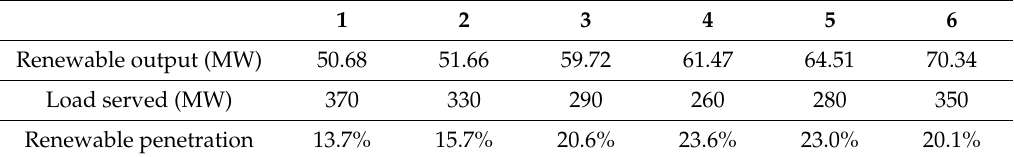
Table 8. The renewable penetration in the case study time step.